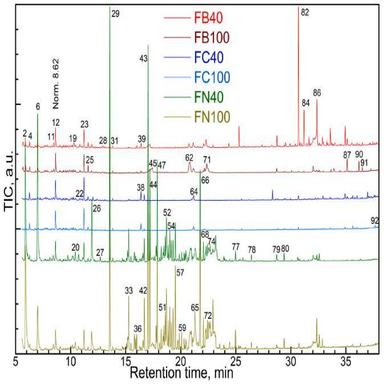
The GC-MSD chromatograms of extractive fractions of fir bark, cones and needles (compound number from.).